Question: What does this figure show? Answer in one sentence.
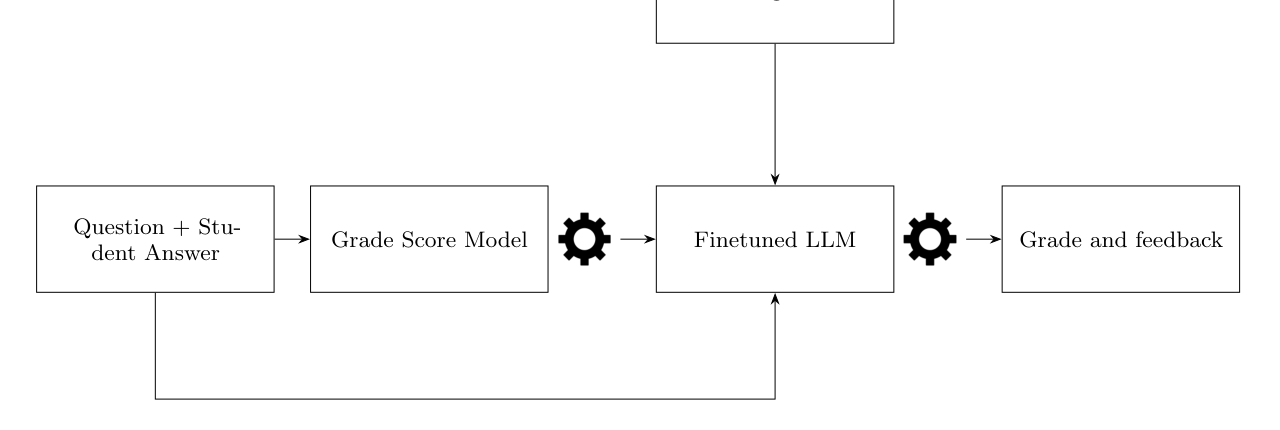
Answer: An overview of our most performant models in terms of grading scores and grading feedback. Assessment questions, student answers, and grading rubrics are supplied as inputs to our grade score and feedback generation models. The grade score model outputs are supplied as input to our finetuned LLMs leading to higher performance. A highly accurate, w.r.t. domain expert ground-truth, grade score and feedback is outputted.